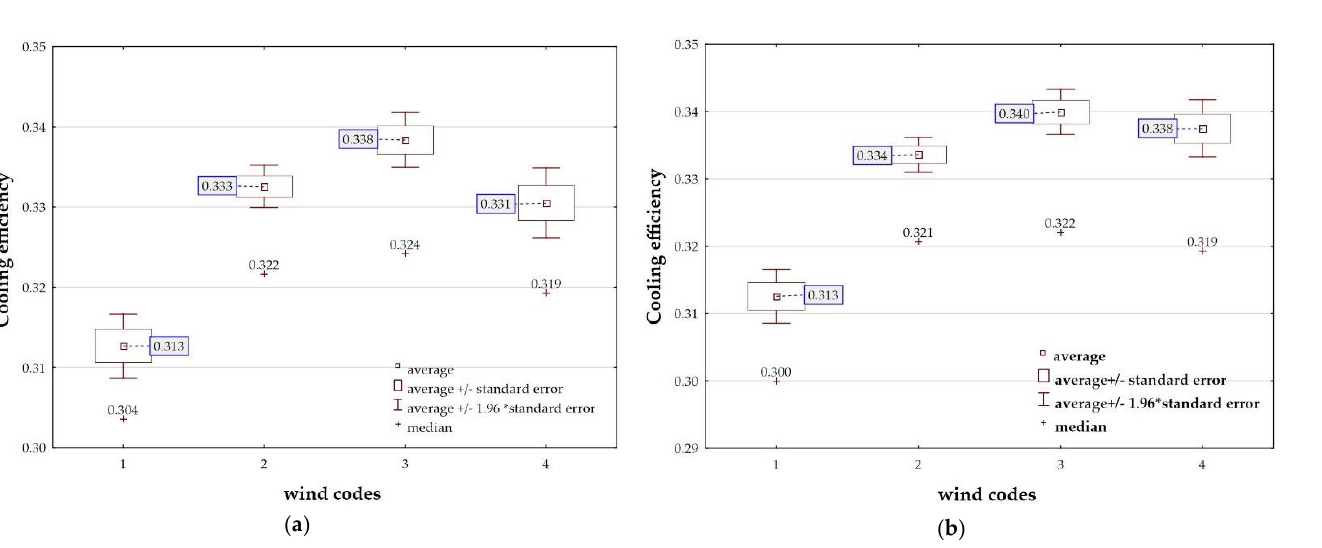
Table 3. Test results for the variable cooling efficiency – 𝜀 [%].